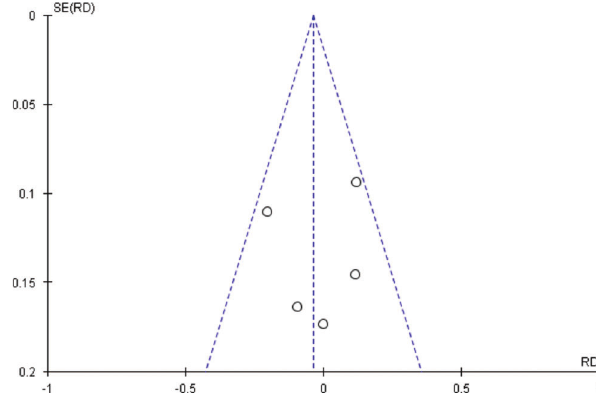
Figure 6 - Funnel plot of major complications in retrospective studies. All studies are inside the funnel plot.